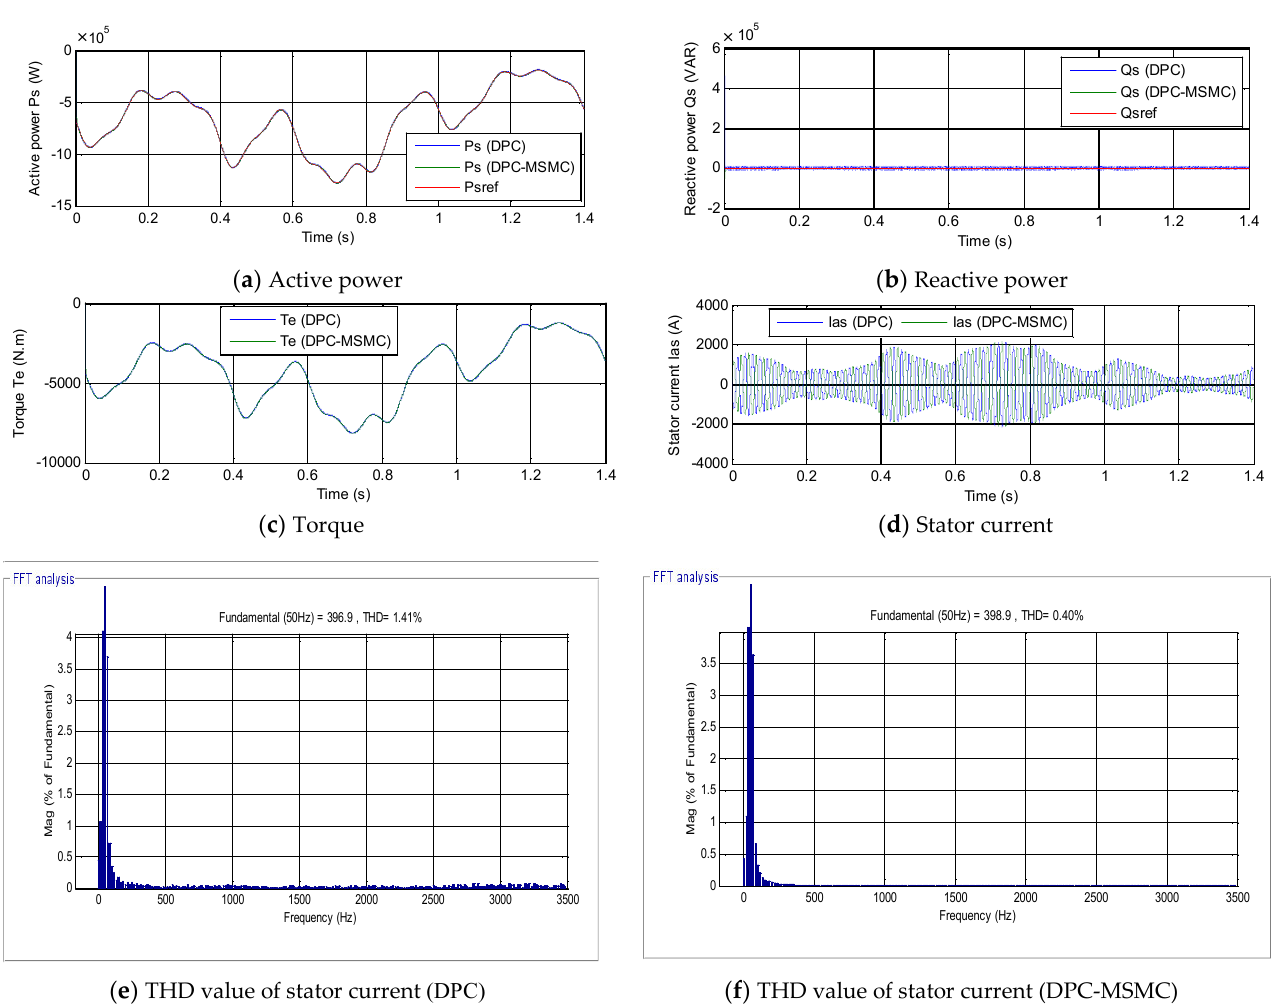
Figure 9. Simulated results from the variable-speed test.